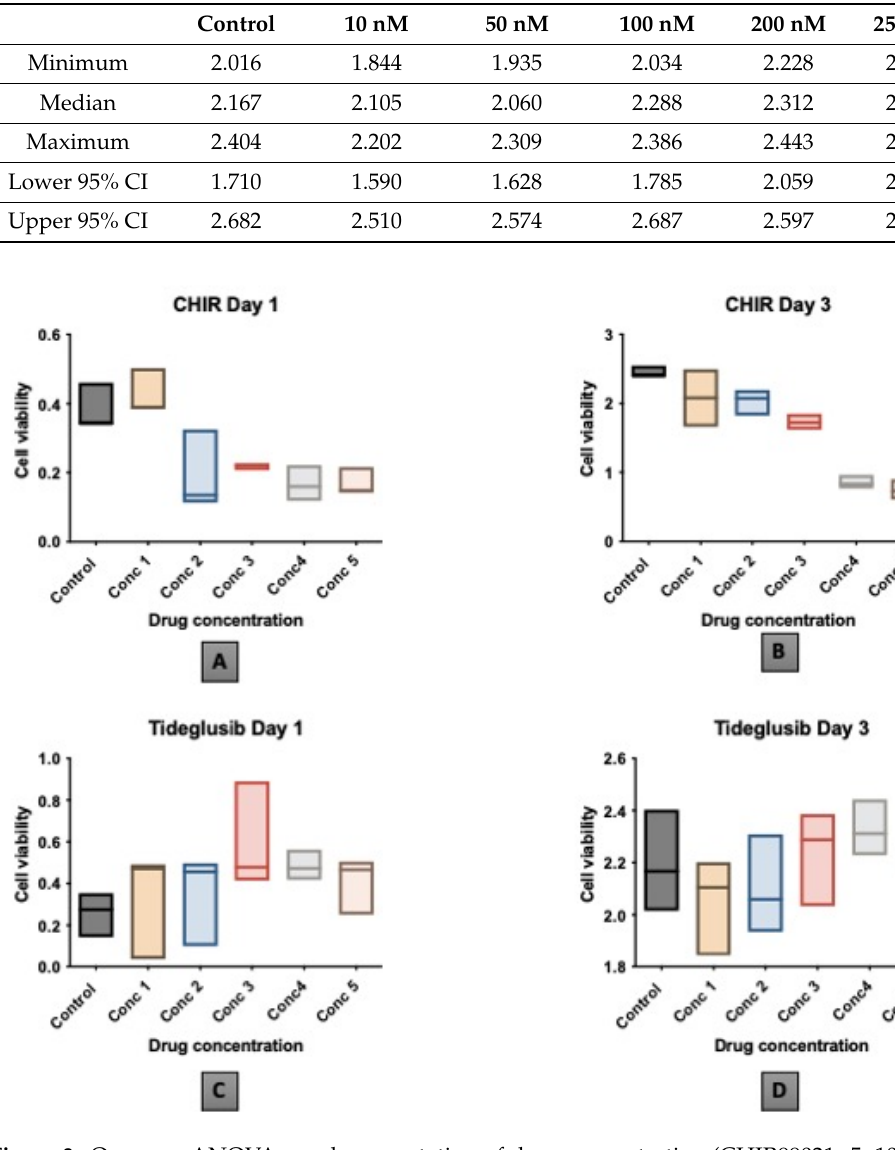
Figure 3. One ‐ way ANOVA graph presentation of drug concentration (CHIR99021: 5, 10, 15, 20, 25 nM and tideglusib: 10, 50, 100, 200, 250 nM) vs. cell viability of: ( A ) CHIR99021 at day 1. ( B ) CHIR99021 at day 3. ( C ) Tideglusib at day 1. ( D ) Tideglusib at day 3. Table 1. CHIR99021 different doses cytotoxicity over hDPSCs at day 3 .